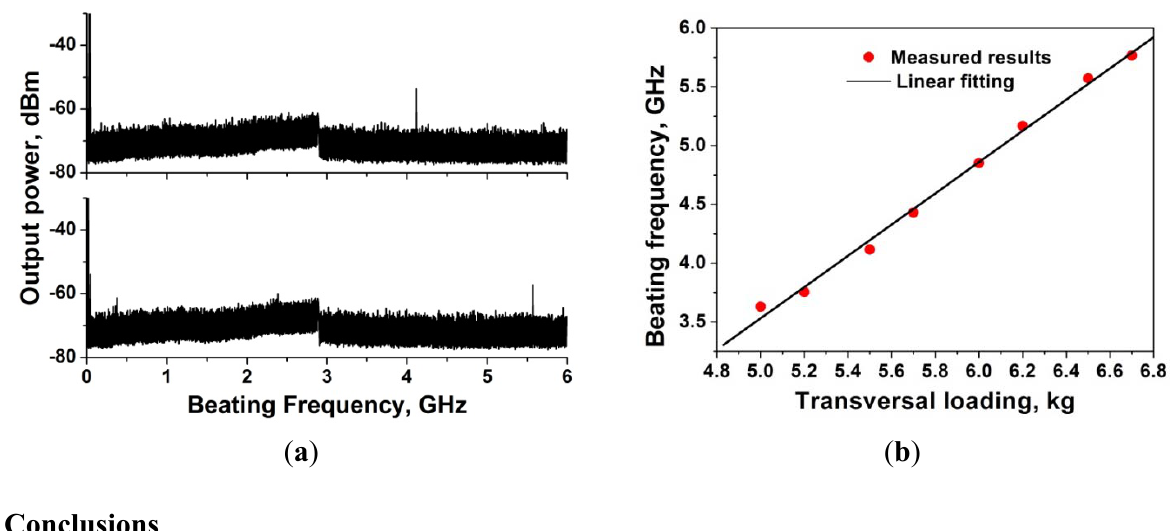
Figure 22. ( a ) The spectra of the beating generated signals when the PSFBG is under different transversal loading and ( b ) the relationship between the value of transversal loading and the frequency of the beating-generated microwave